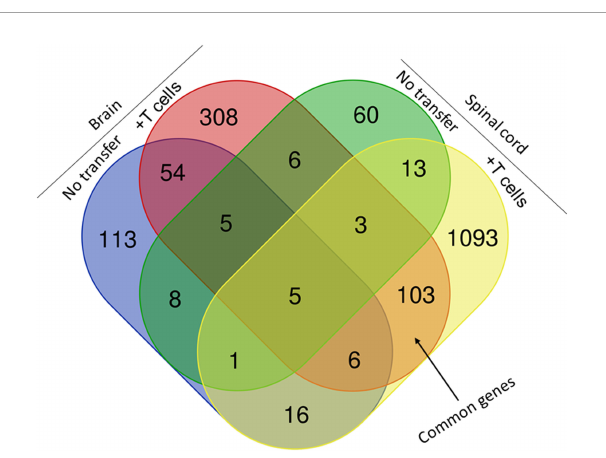
FIGURE 9 Comparison of transcriptome analysis of upregulated and downregulated common genes in cells isolated from brain and spinal cord of infected mice with demyelination. The transcriptomes of cells isolated from brains and spinal cords of HSV-IL-2-infected IL-17A -/- mice with and without T cells transfer and described above in Figure 8 were compared after normalization with that of their uninfected counterparts. In mice that received T cells and showed demyelination, we detected 103 genes in common between the brain and spinal cord. In mice with CNS demyelination 60 of the common genes were upregulated, while 43 genes were down regulated. Data are based on three independent